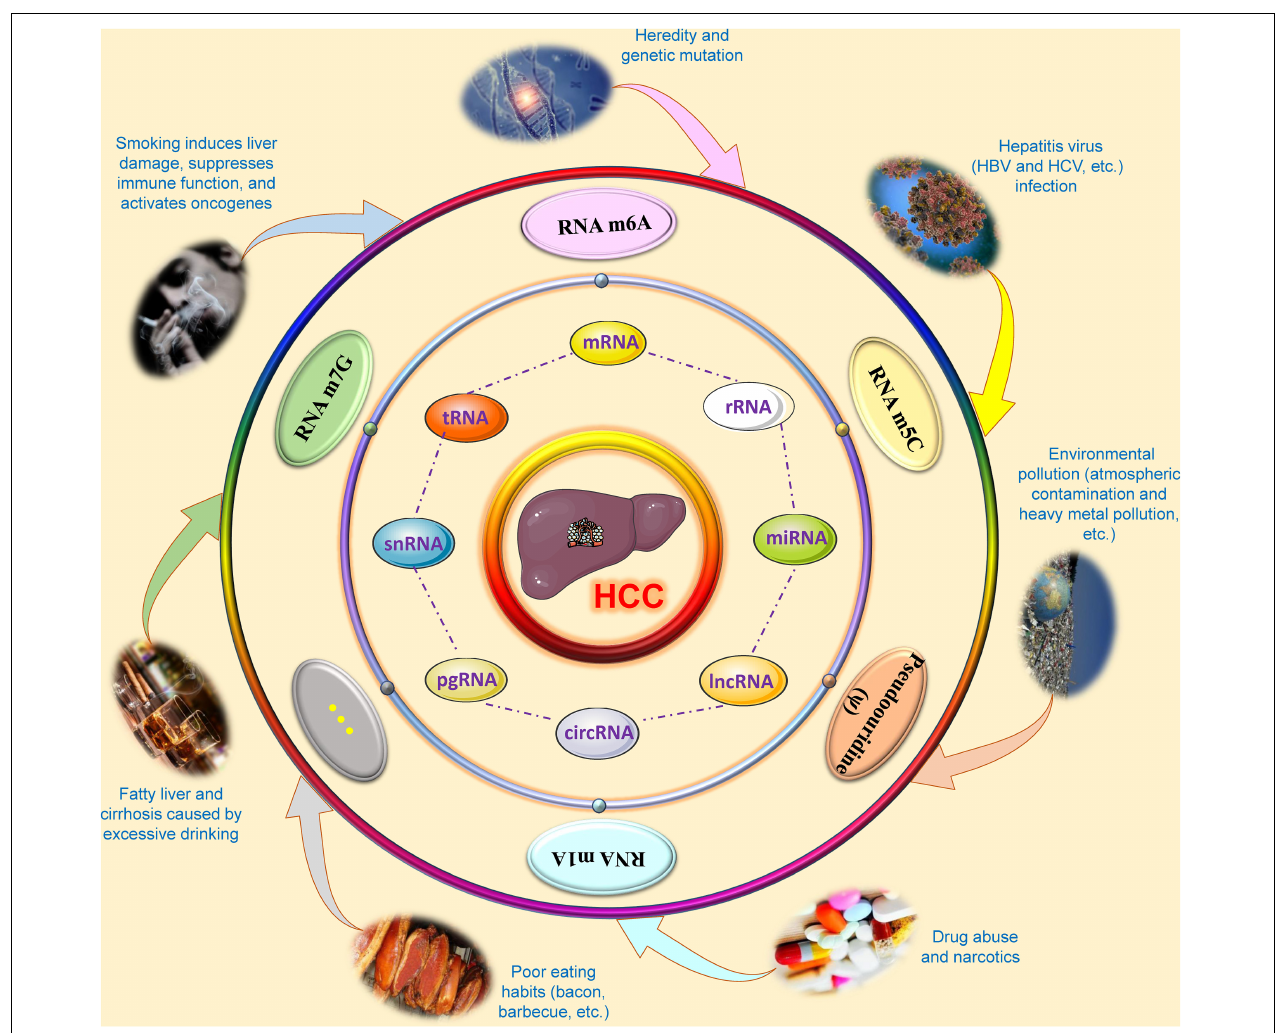
FIGURE 1 | Overview of research on RNA epigenetic modifications of hepatocellular carcinoma. During the carcinogenesis and development of hepatocellular carcinoma, a variety of factors, such as smoking, alcohol, environmental pollution, viral infection, poor eating habits, drug abuse and narcotics may cause abnormal changes in epigenetic modifications in several kinds of RNAs based on genetic susceptibility, including N6-methyladenosine (m6A), 5-methylcytosine (m5C), N1-methyladenosine (m1A), N7-methylguanosine (m7G), and pseudouridine ( ψ ). These RNA epigenetic modifications will affect the metabolic and functional processes of RNA, such as RNA structure, splicing, stability, maturation, transport, translation, and degradation, by modifying the base or pyrimidine at a specific site of coding RNA and non-coding RNAs. These abnormalities in RNAs will affect the occurrence and progression of hepatocellular carcinoma through specific signal transduction or interactions. CircRNA, Circular RNA; HBV, Hepatitis B virus; HCC, Hepatocellular carcinoma; HCV, Hepatitis C virus; lncRNA, Long non-coding RNA; m1A, N1-methyladenosine; m5C, 5-methylcytosine; m6A, N6-methyladenosine; m7G, N7-methylguanosine; mRNA, Messenger RNA; miRNA, microRNA;